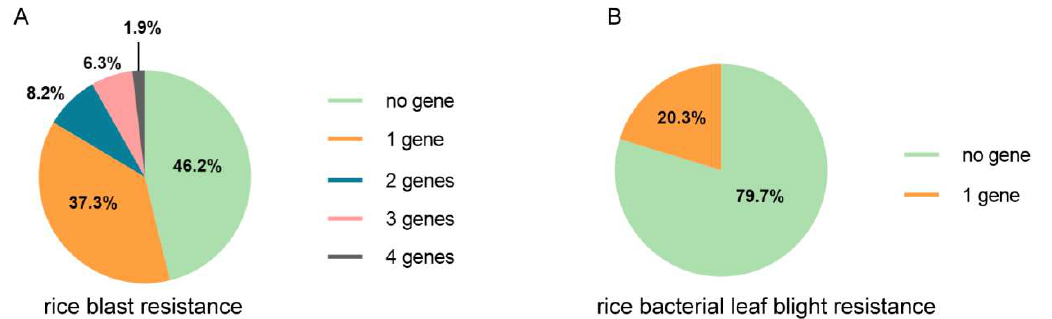
Figure 4. The summary of the existence of rice blast genes and rice bacterial leaf blight resistance genes in the local varieties in the Yunnan province. The proportion of varieties that harbor a different number of rice blast resistance genes ( A ) and rice bacterial leaf blight resistance ( B ).